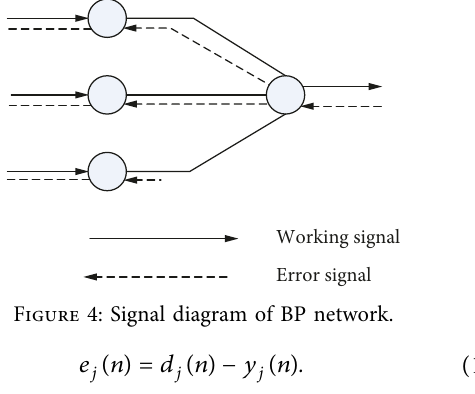
Figure 4: Signal diagram of BP